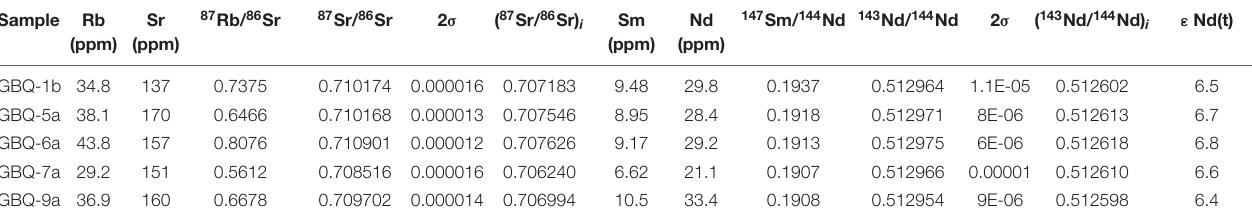
TABLE 2 | Sm-Nd and Rb-Sr isotopic analytical results of the Gubaoquan dolerite dykes in the Beishan area, NW China. Sample Rb